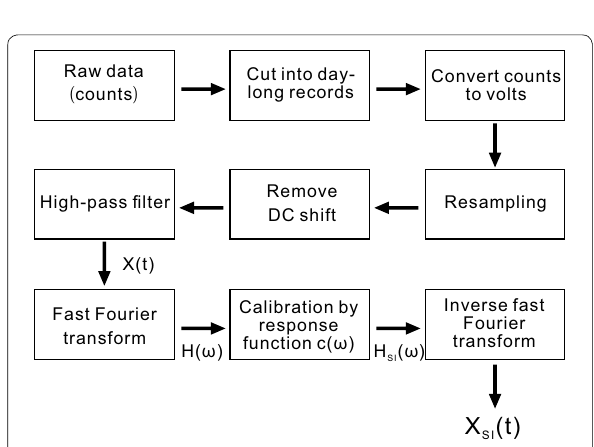
Fig. 5 Schematic data-processing sequence. The stages of the transformation to nT from X ( t ) to X SI ( t ) are inserted between the boxes representing operations in the processing